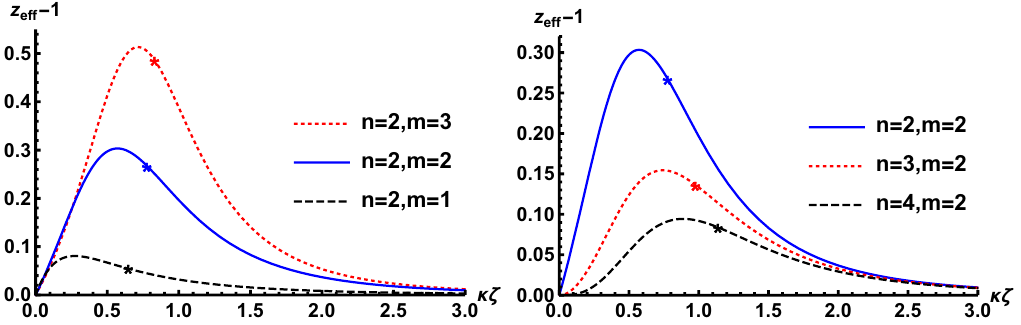
Figure 3 . Relative e(cid:11)ective anisotropy exponents z e(cid:11) (cid:0) 1 for boomerang (cid:13)ows for Q f = 1. Left: all the curves have the same n = 2, while the di(cid:11)erent curves correspond to m = 1 (dashed black), m = 2 (blue), and m = 3 (dotted red). Right: all the curves have the same m = 2, but this time we vary n = 2 (blue), n = 3 (dotted red), and n = 4 (dashed black). The maximal exponent decreases with increasing n , but increases with m